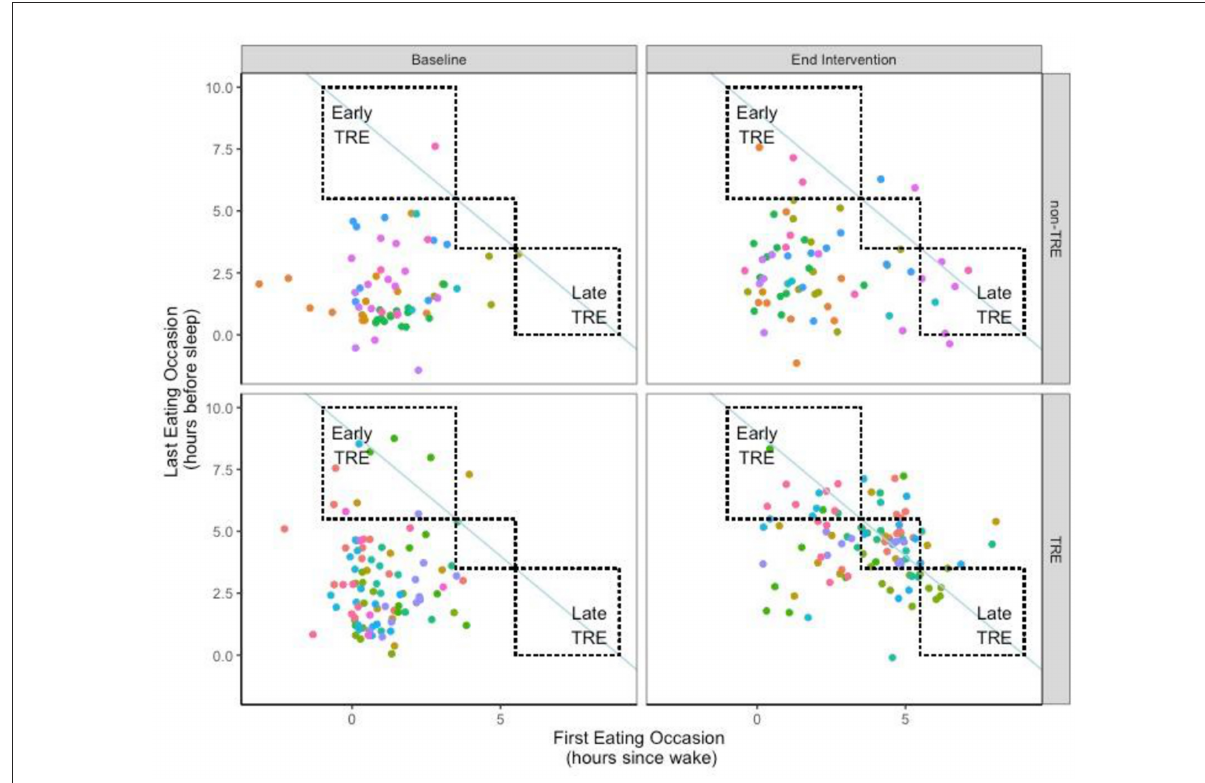
FIGURE1 Timing of eating for each day at Pre- and End-Intervention. Individual participants are represented by different colored points. The non-TRE participants are depicted on the top, while the TRE participants are depicted on the bottom; each participant is depicted once at both Baseline (Left) and End Intervention (Right) . A shift toward the line of identity (blue solid line), would be indicative of a shortened eating window consistent with TRE. (Upper left) box represents an early-TRE eating pattern, whereas the lower right box represents a late TRE eating pattern. The middle box represents an intermediate-TRE eating pattern which the timing of the first and last meals were shifted by similar magnitudes.